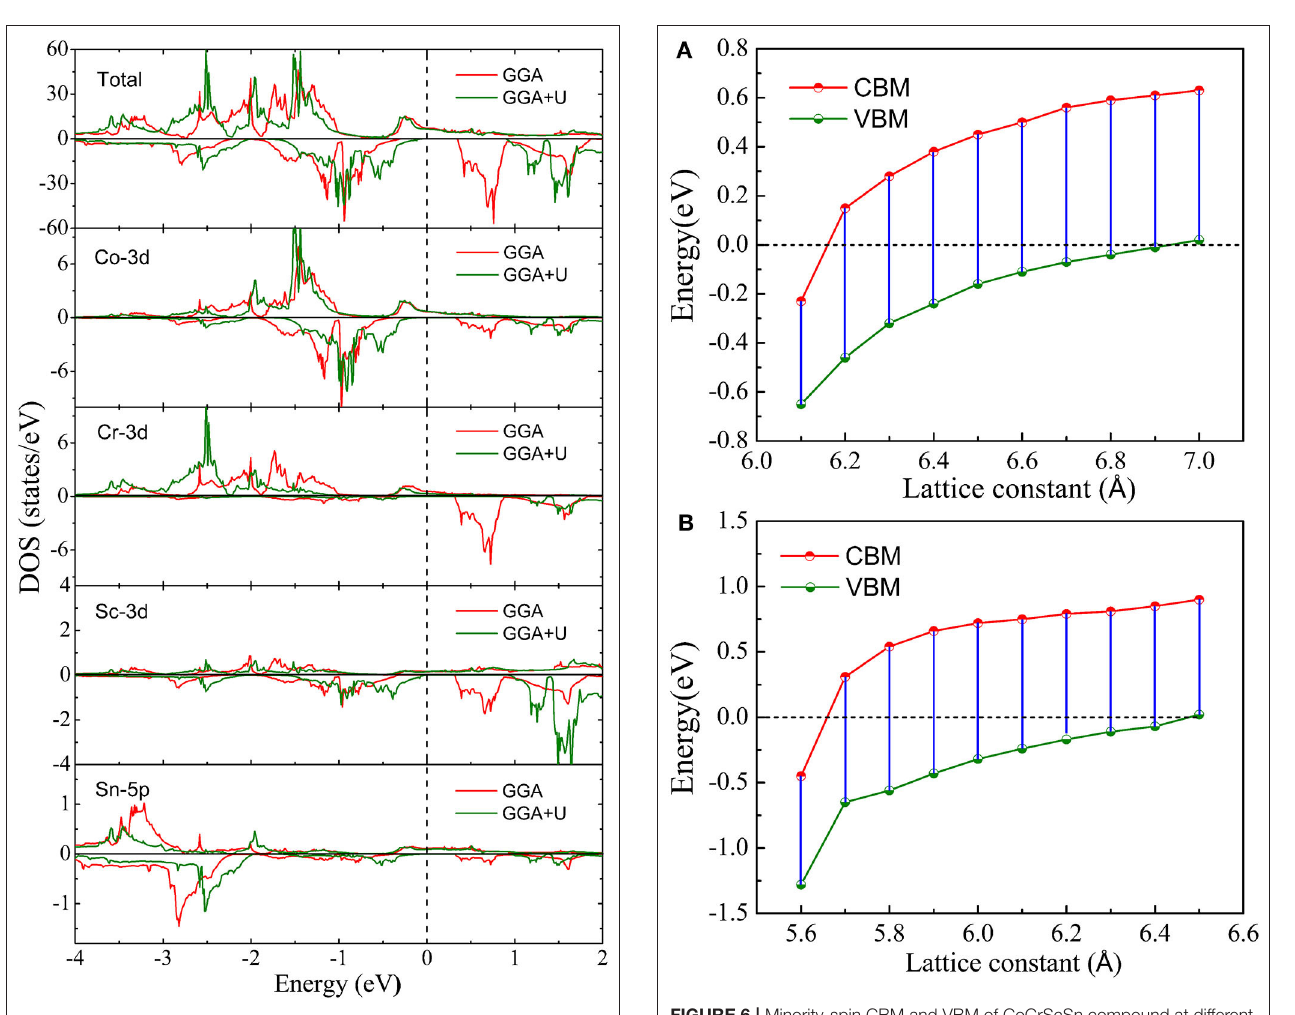
FIGURE 5 | Total and local density of states of CoCrScSn compound under GGA and GGA + U, respectively.